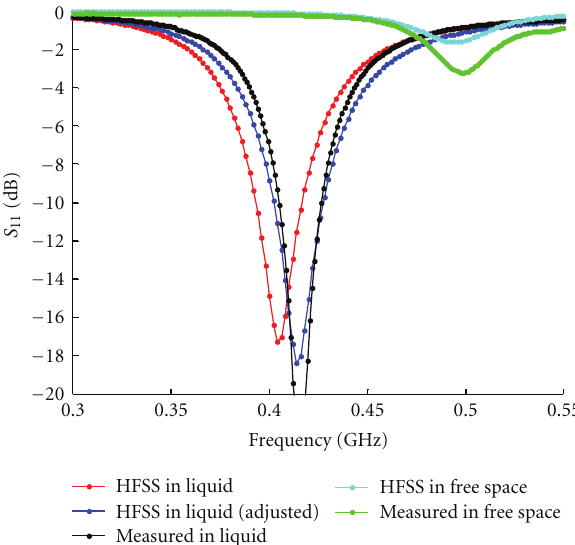
Figure 10: Measured resonant frequencies of implantable antenna in free space and in tissue-equivalent